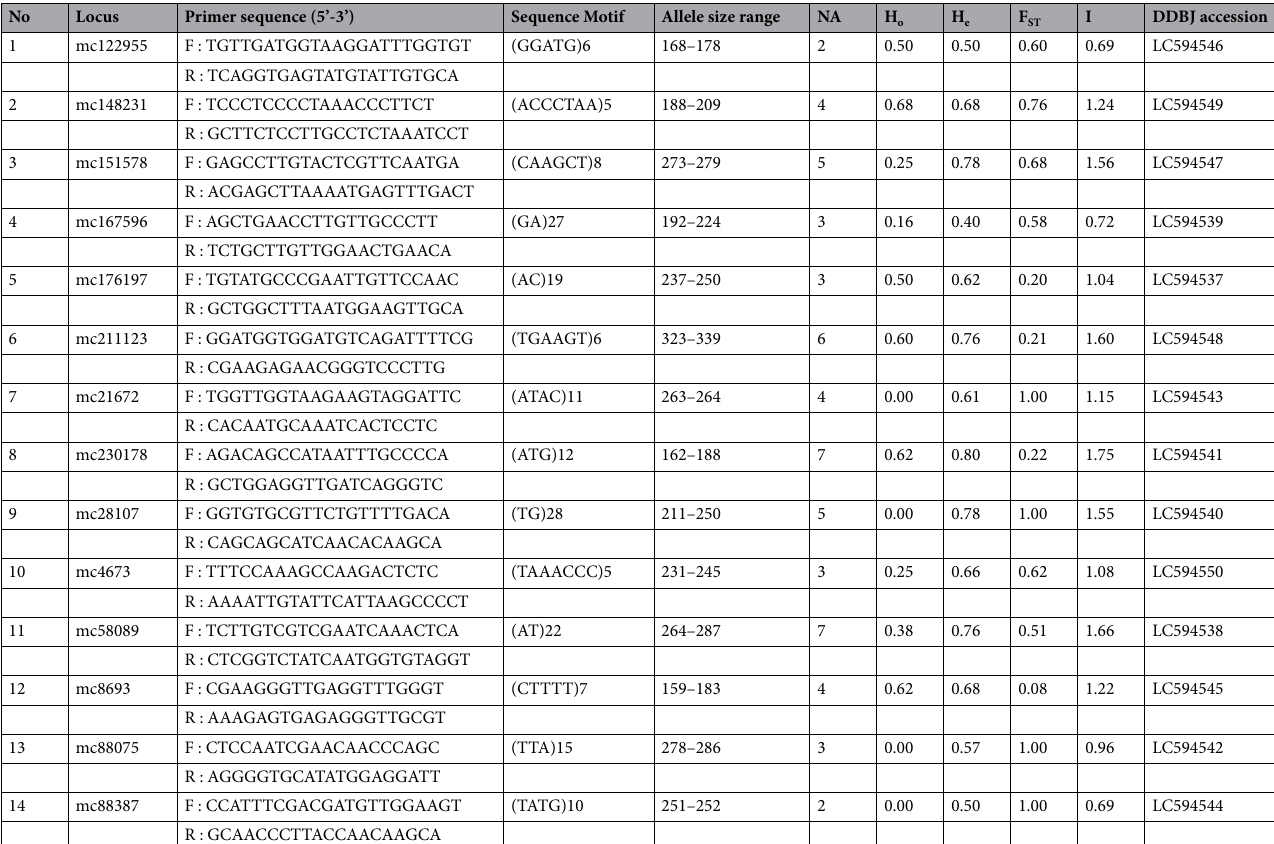
Table 4. Summary statistics of the fourteen analyzed microsatellite loci. F forward primer sequence, R reverse primer sequence, NA number of alleles, H o observed heterozygosity, H e expected heterozygosity, F ST fixation index, I Shannon’s information index.